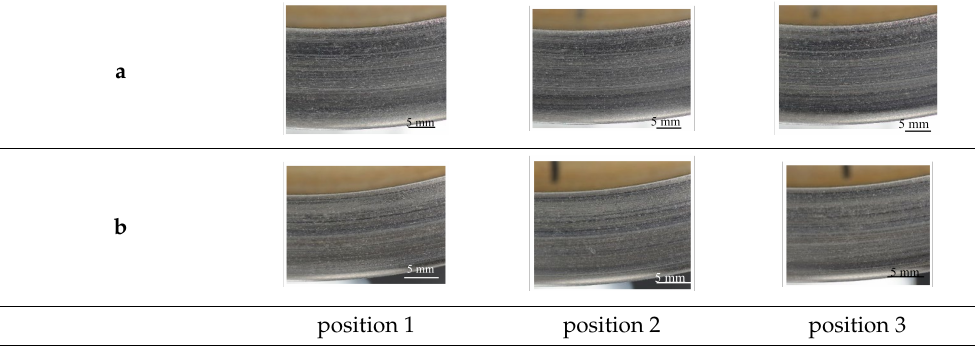
Table 7. Images of the rubbed disc surfaces for ( a ) M1 and ( b ) M2 taken at different angular positions.